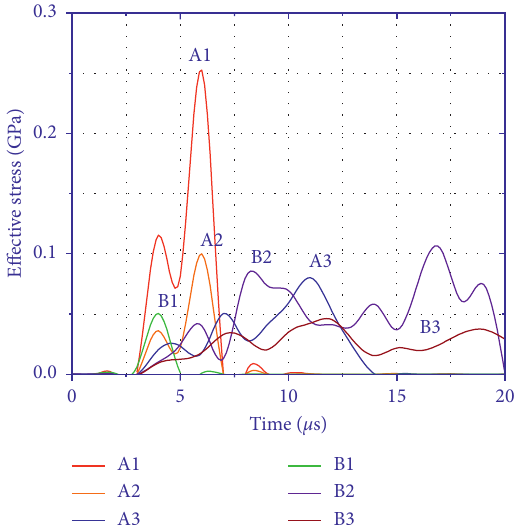
Figure 15: Stress curve of hydraulic charge blasting unit.